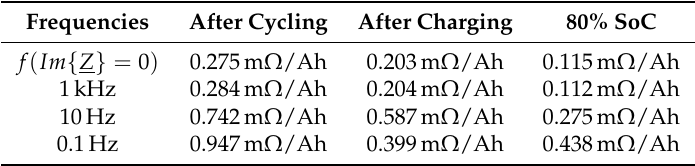
Table 2. The average slopes of impedance amplitude increase over capacity loss C loss for different frequencies and states from − 1I 20 impedance